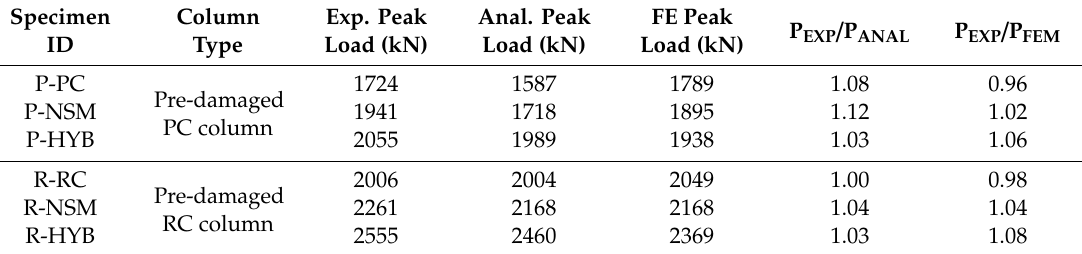
Table 4. Comparison of peak strength from tests with the analytical and